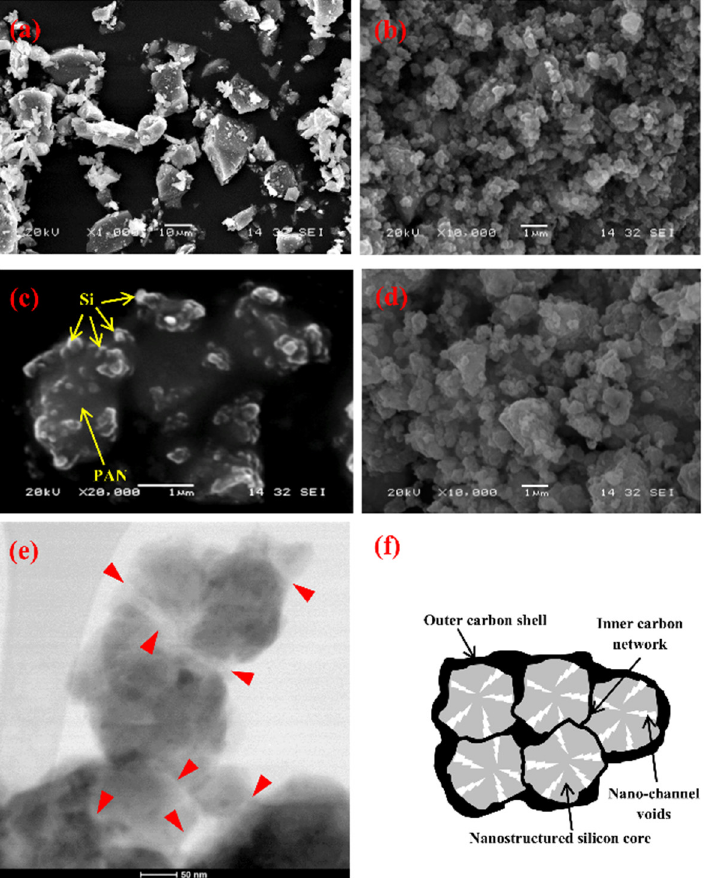
Figure 1. SEM images: ( a ) silicon powder before ball milling, ( b ) Si/PAN powder after ball milling, ( c ) a close view of Si/PAN powder after ball milling (arrows showing Si nanoparticles embedded in a PAN matrix), and ( d ) the final product of Si@void@C powder. ( e ) STEM image of several Si@void@C particles (arrows indicating the presence of nano-channel shaped voids), and ( f ) sche-